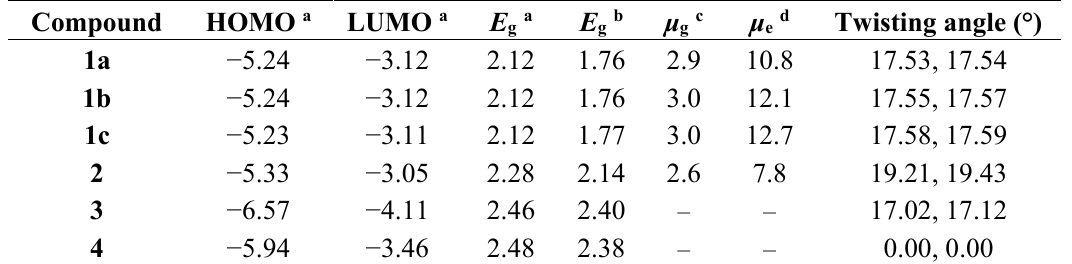
Table 2. Calculated and experimental parameters for perylene bisimide